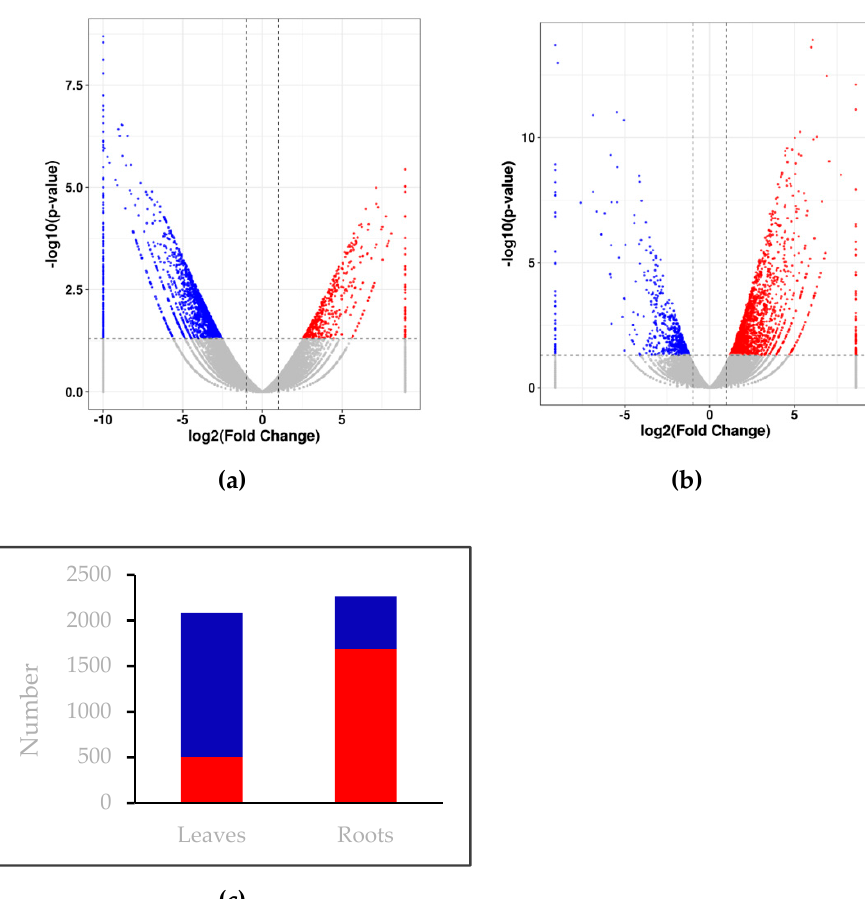
Figure 1. Volcano Plot of di ff erentially expressed genes (DEGs) between the control and low nitrogen stress of wheat seedlings leaves ( a ) and roots ( b ). The two vertical dotted lines are twice of the di ff erence threshold, and the horizontal dotted line represents p -value is 0.05. The red dots indicate the up-regulated genes in this group, the blue dots indicate the down-regulated genes in this group, and the gray dots indicate the non-significant differentially expressed genes. ( c ) Number of genes up- and down-regulated in leaves and roots. The red column indicate the number of up-regulated genes, while the blue column indicate the number of down-regulated genes.